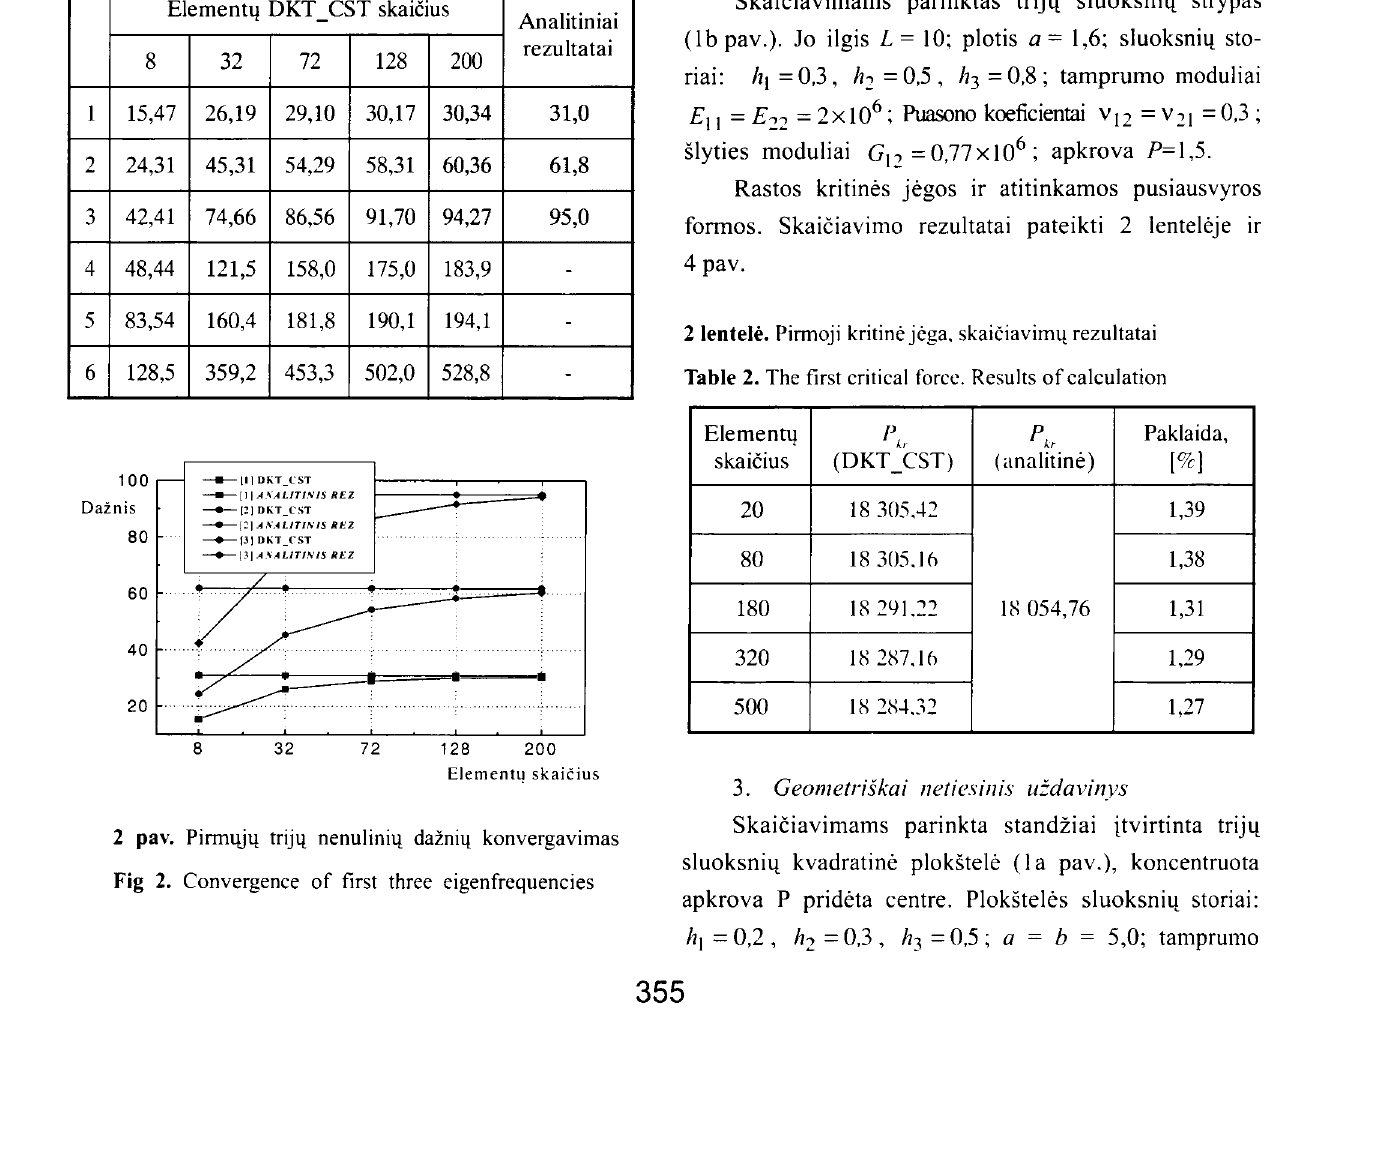
Skaiciavimo rezultatq palyginimas su analitiniais [8] sprendiniais pateiktas 2 pav. ir I lenteleje. Nagrineja mos ploksteles pirmosios sesios nulines formos atitinka kietojo kiino judesius. Nenulines formos pateiktos 3 pav. Table 1. The first six non-zero eigenfrequencies Elementq DKT _CST skaiCius